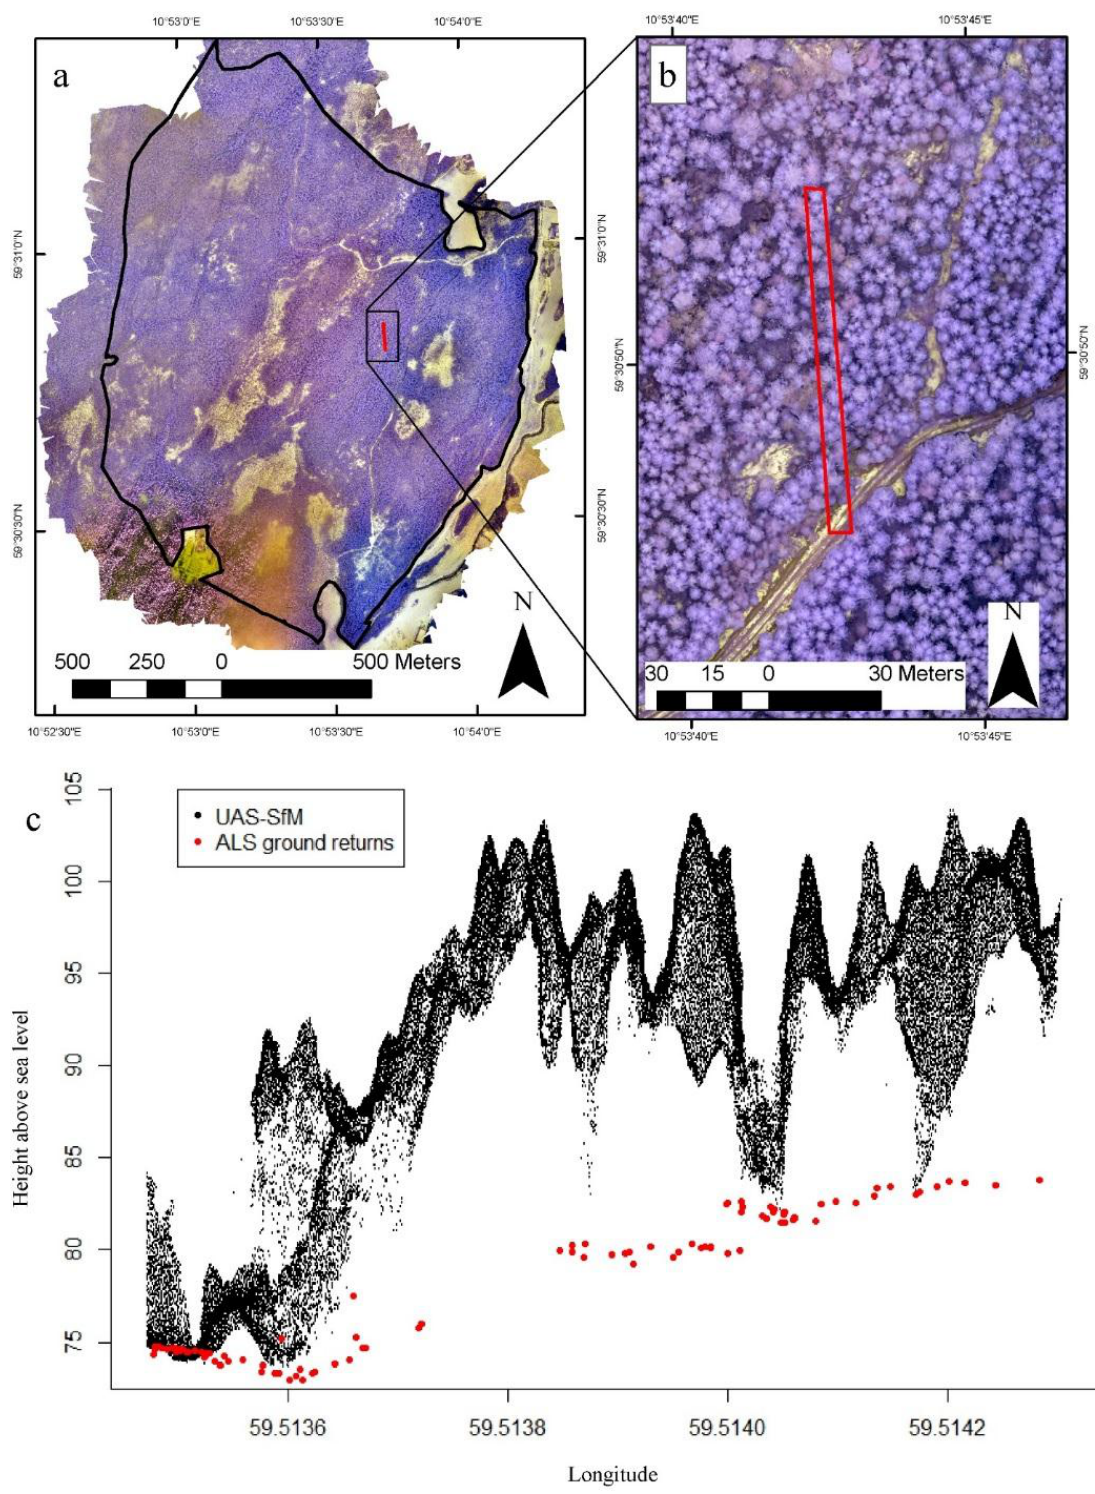
Figure 3. Overview of the data used in the study. ( a ) Orthophoto mosaic of the total inventory area shown only for visualization purposes; ( b ) detail of the orthophoto mosaic showing the high resolution of the imagery, including the transect; ( c ) transect showing the vertical distribution of the UAS-SfM point cloud (in black) and the corresponding ALS ground returns (in